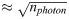
Low-fraction regime.(A) Samples of dyes with short-lifetime (Erythrosin B) and long-lifetime (Coumarin 153) were prepared, and fluorescence lifetime measurements were collected for each dye separately, leading to separate master photon histograms. Test histograms were constructed by randomly sampling a fixed number of photons, with varying fractions being drawn from the master lists of short-lifetime and long-lifetime photons. These histograms were then analyzed in order to estimate the fraction of short-lifetime photons, fS. (B) The estimated short-lifetime fraction, fS, varies linearly with the constructed short-lifetime fraction for three different total photon numbers, with a small offset. Squares: estimate from posterior mode. Dots: estimate from posterior mean. Dashed lines: linear fits with slopes 0.9933 ± 0.0026, 1.0085 ± 0.0024, and 1.0106 ± 0.0031, and offsets of 0.002000 ± 0.0484 × 10−4, 0.004400 ± 0.0814 × 10−4, and 0.009500 ± 0.1992 × 10−4 for low, medium, and high intensities respectively (95% confidence interval). Intensities correspond to data collected at ≈1.5 × 105, 1.2 × 106, and 4.8 × 106 counts per second, for low, medium, and high intensity respectively. Inset: Data from main figure shown on a log-log scale. (C) Changes in the estimated short-lifetime fraction track the known changes in the short-lifetime fraction. Squares: estimate from posterior mode. Dots: estimate from posterior mean. Dashed lines: Linear fits with slopes of 0.9573 ± 0.1895, 1.0013 ± 0.1445, and 0.9580 ± 0.1717, and offsets of (0.2332 ± 0.3712) × 10−5, (0.3215 ± 0.3088) × 10−5, and (0.4617 ± 0.4286) × 10−5 for low, medium, and high intensities respectively (95% confidence interval). (D) Sample standard deviations decrease with increasing photon number as ≈nphoton Squares: Posterior standard deviation Dashed line: power law fit to all intensities with exponent −0.4764 ± 0.0471 (95% confidence interval).